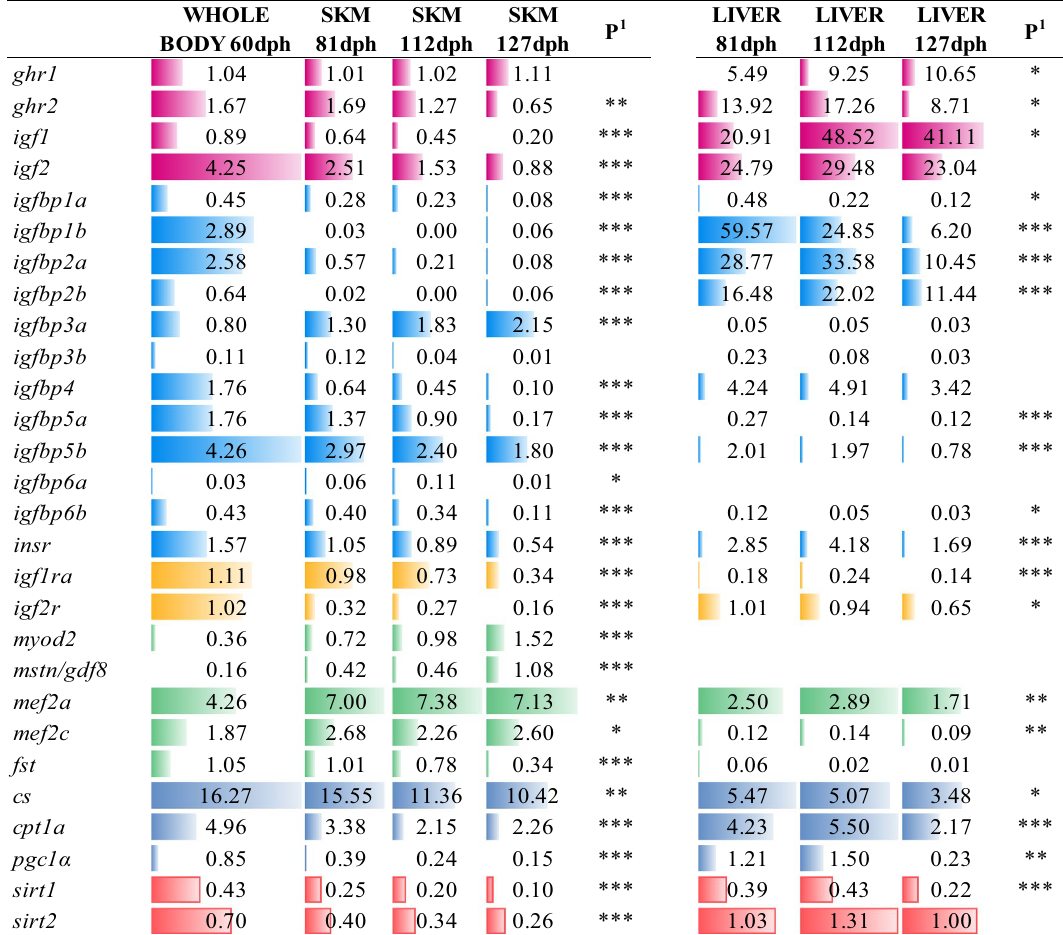
Table 2. Relative gene expression profiling of whole body, skeletal muscle and liver of gilthead sea bream during early stages (60–127 dph). Data are the mean of 6 fish. Values of skeletal muscle were in reference to the expression level of igf2r of whole body with an arbitrary assigned value of 1. Values of liver were in reference to the expression level of igf2r in fish sampled at 81dph with an arbitrary assigned value of 1. Bar colors represent the magnitude of change within a given gene category: ghr/igf (pink), igfbp (light blue), insr/igfr (yellow), muscle cell proliferation and differentiation factors (green), oxidative markers (dark blue) and energy sensors (red). 1 P -values. Asterisks indicate significant differences for whole body/ skeletal muscle and liver